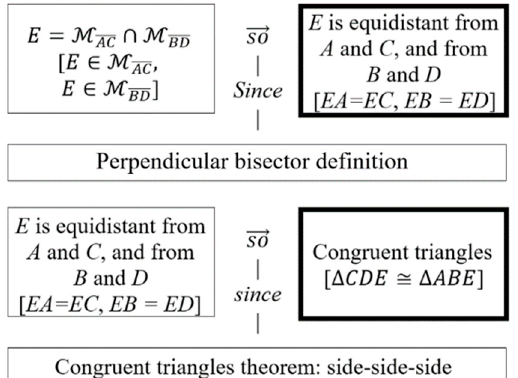
Figure 6. Deductive argument to validate ∆ CDE ∼ = ∆ ABE . ( M (cid:3025)(cid:3026)(cid:3364)(cid:3364)(cid:3364)(cid:3364) indicates perpendicular bisector line of (cid:1850)(cid:1851)(cid:3364)(cid:3364)(cid:3364)(cid:3364) . Armando did not use this symbol because his language is oral).